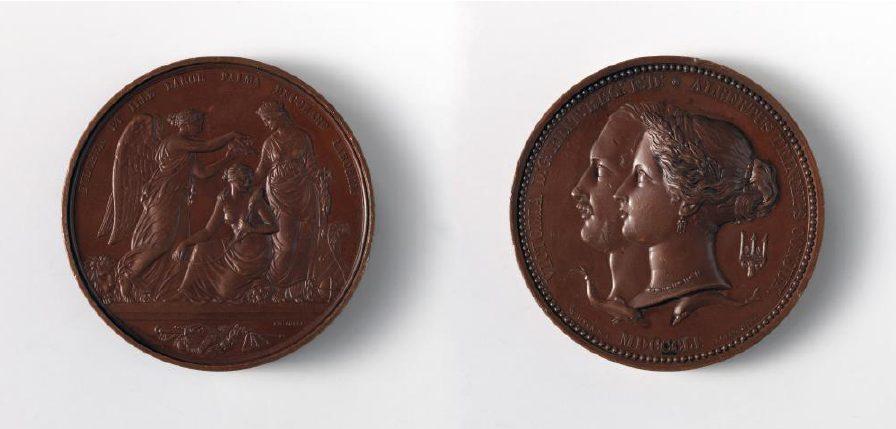
Figure 1. Juror’s medal awarded to Dr. James Arnott, Great Exhibition of London, 1851, for his development of cold therapy equipment (reproduced from the Metropolitan Museum of Art, New York City, used under a Creative Commons Attribution 1.0 Universal Public Domain Dedication).